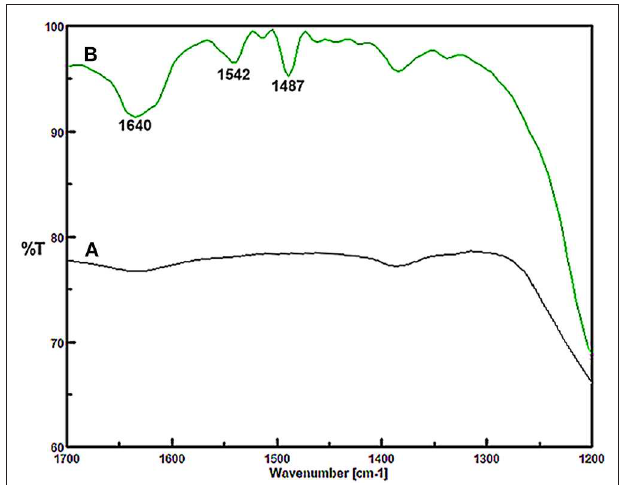
3 O 4 @OS-SO 3 H nanocatalyst and (B) Fe 3 O 4 @OS-SO 3 H nanocatalyst after pyridine adsorption.